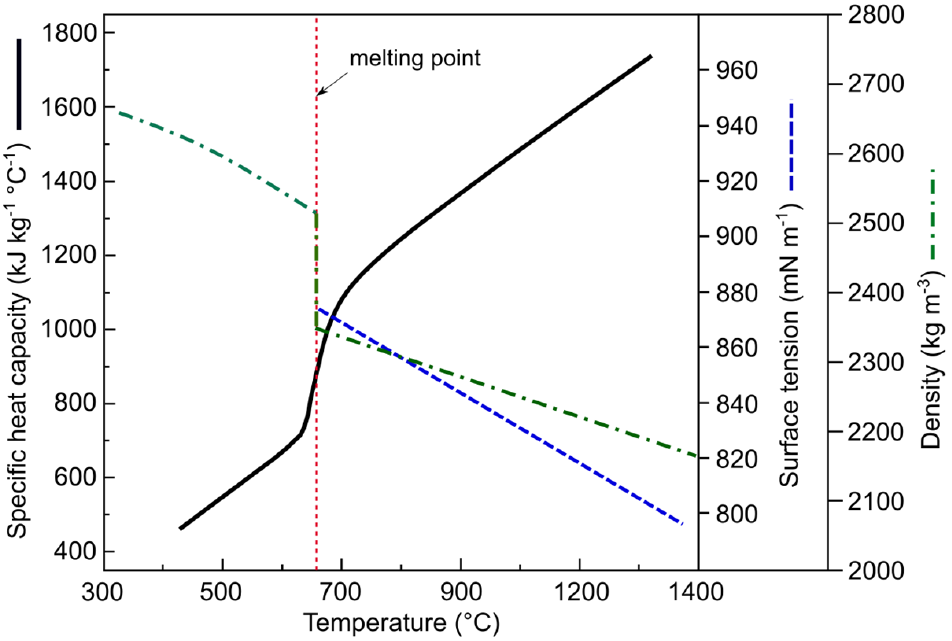
Figure 2. Thermophysical properties of aluminium. Based on [20].